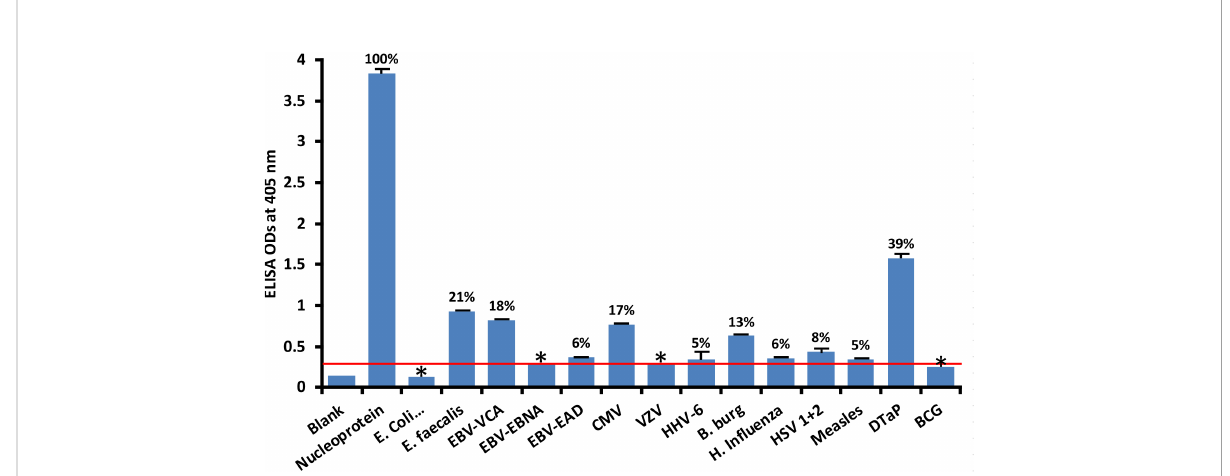
FIGURE 2 Reaction of human SARS-CoV-2 nucleoprotein monoclonal antibody with nucleoprotein and different bacterial and viral antigens, including DTaP and BCG vaccines. At 3SD above the OD of background or 0.3, signi fi cant reaction between spike protein antibody and bacterial and viral antigens was observed. Each determination of antigen-antibody reaction was performed in quadruplicate. The SDs for all the reactions were less than 0.12, and are shown as error bars. In these experiments, when monoclonal anti-SARS-CoV-2 antibodies were replaced with sera from healthy subjects, non-signi fi cant reactions with a mean of 0.29 were observed from the sera with nucleoprotein. The ODs of these reactions were lower than 0.3. Percentages of signi fi cant reactivity are also shown. DTaP is shown to be the most reactive. * = Antigens whose reactions were under the cutoff and/or close to the